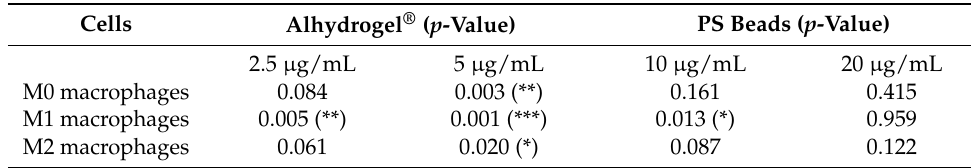
Table 3. Statistic evaluation of cellular lactate content after incubation with Alhydrogel ® and PS beads. A paired two-tailed student’s t -test was used to calculate the p -values. p -values < 0.05 (*), <0.01 (**), and <0.001 (***) were considered significant.